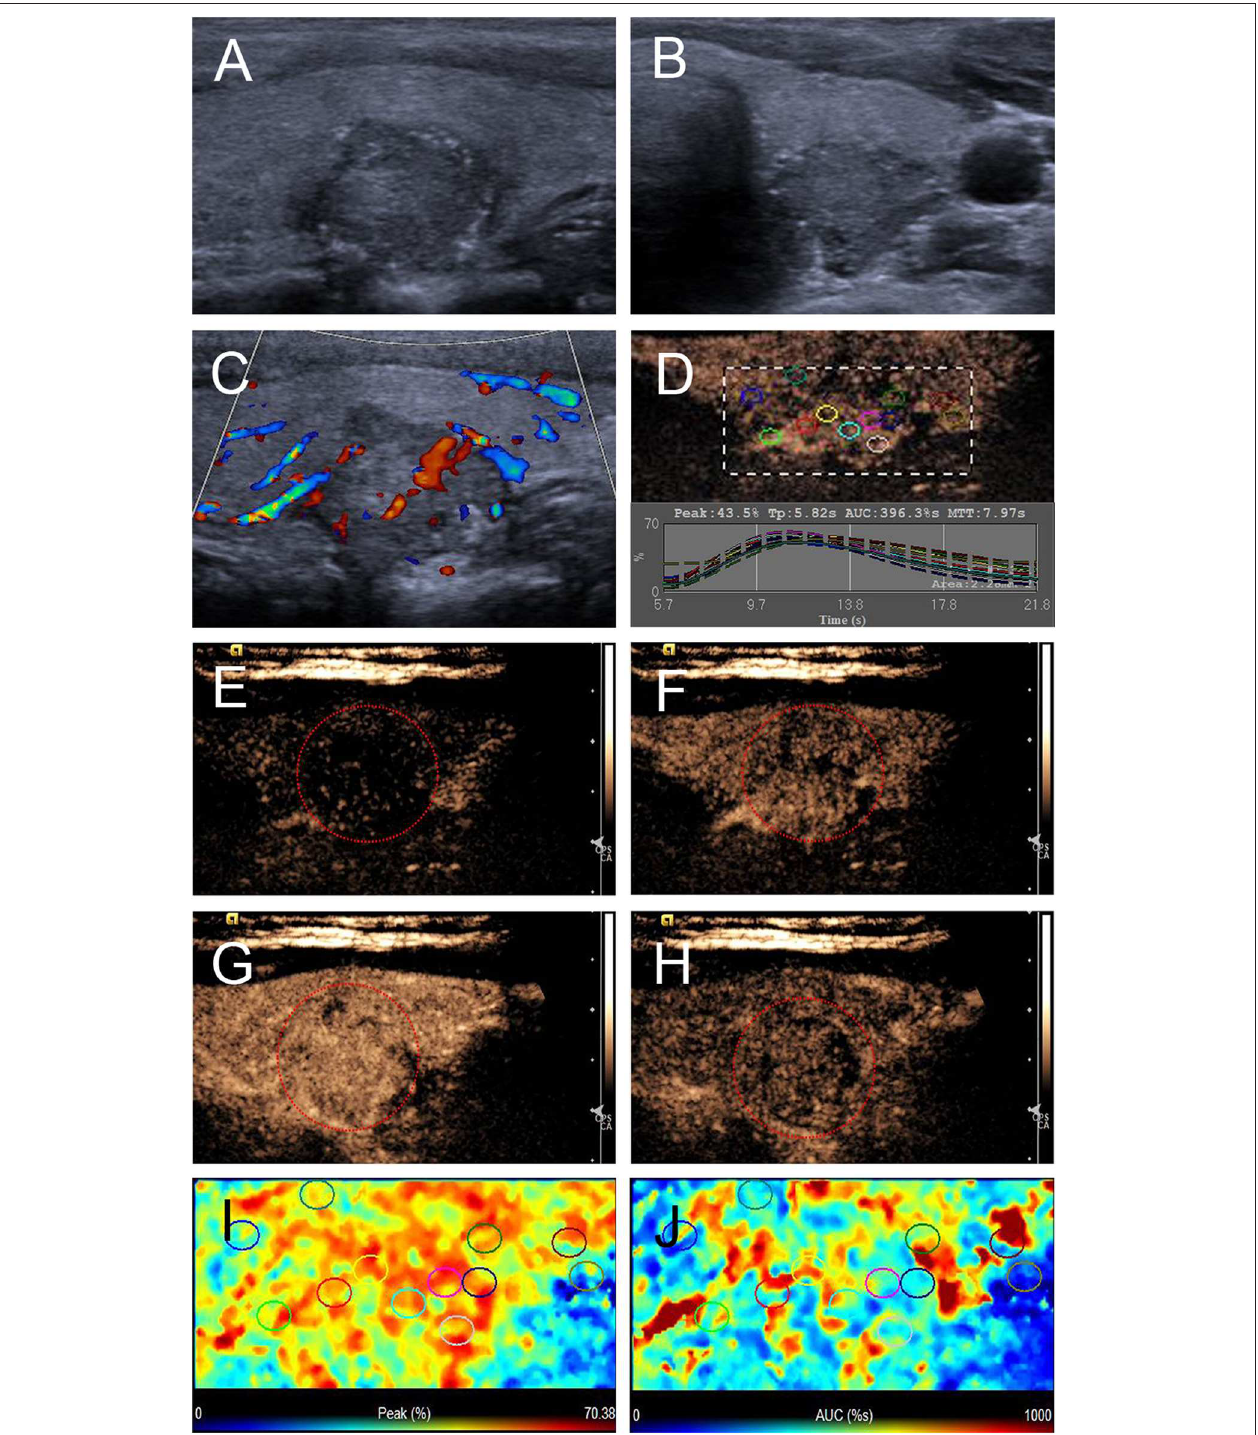
FIGURE 4 | Ultrasound images of a 26-y-old female PTC patient with petal-like calcification of the left thyroid lobe. (A) Longitudinal and (B) horizontal gray-scale sonograms; the thyroid nodule had a solid component, hypoechoic echogenicity, ill-defined margin, and capsule contact with protrusion. (C) Color Doppler sonogram showed moderate internal and peripheral vascularies. (D) TICs of the thyroid nodule and peripheral thyroid parenchyma with different regions of interest (different color circles). (E–H) CEUS sonograms of the thyroid nodule (E) at 6s (wash-in), (F) 9s (wash-in), (G) 11s (time to peak), and (H) 15s (wash-out), revealing diffuse, and heterogeneous enhancement (circle) across the whole lesion. (I) Parametric color map showing that peak intensity values for the nodule were mixed with red and yellow, and adjacent thyroid parenchyma were blue and yellow, indicating that the peak intensity of the nodule was higher than that of the peripheral thyroid parenchyma. (J) Parametric color map showing that AUC values for the nodule were mixed with blue, yellow and red, and adjacent thyroid parenchyma were almost the same, indicating that the AUC of the nodule was equal to that of the peripheral thyroid parenchyma.